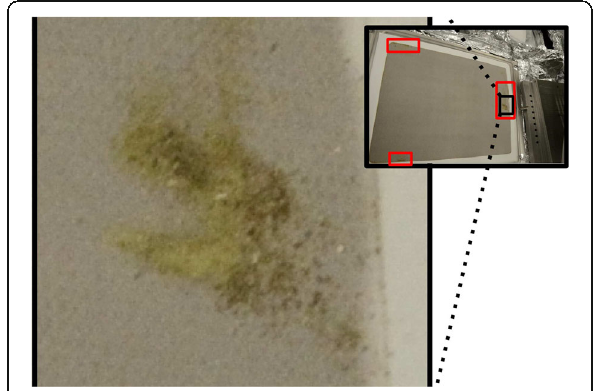
Fig. 5 Picture of a typical backup filter sampled at the GC site in spring (April 2014). We found many coarse particles, which include pollen and coarse soil/mineral dusts, in the areas indicated by the red rectangles